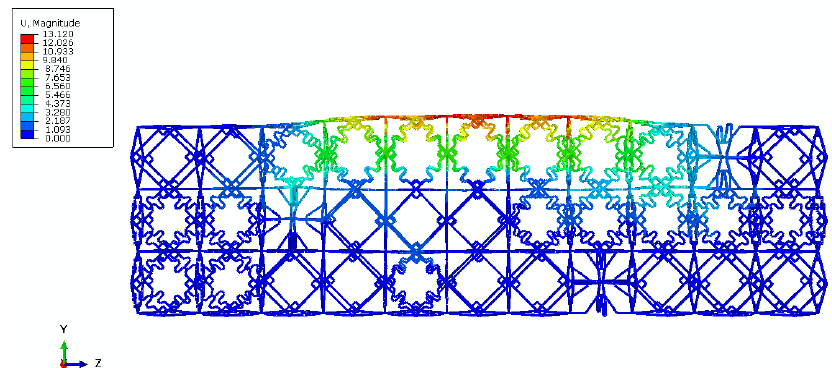
Figure 23. The finite element analysis result of the optimal cell arrangement.